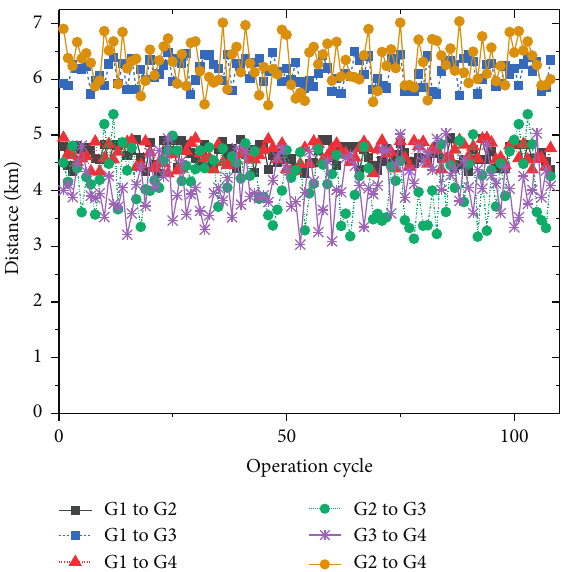
Figure 11: Relative horizontal distance between gliders in one task